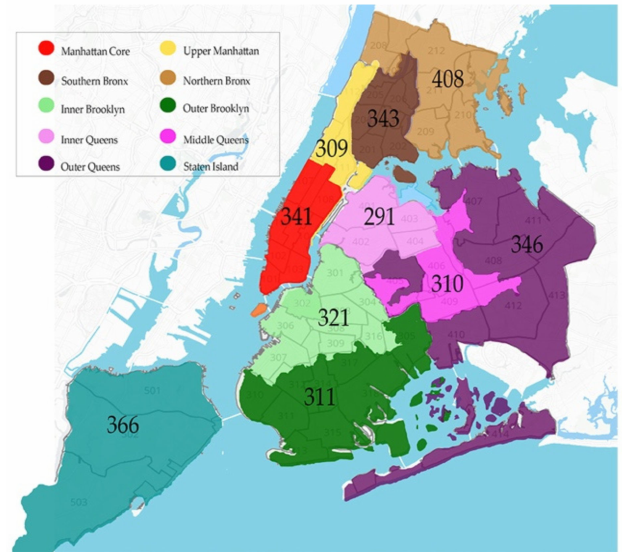
Figure 1. Distribution of participants based on their residential place